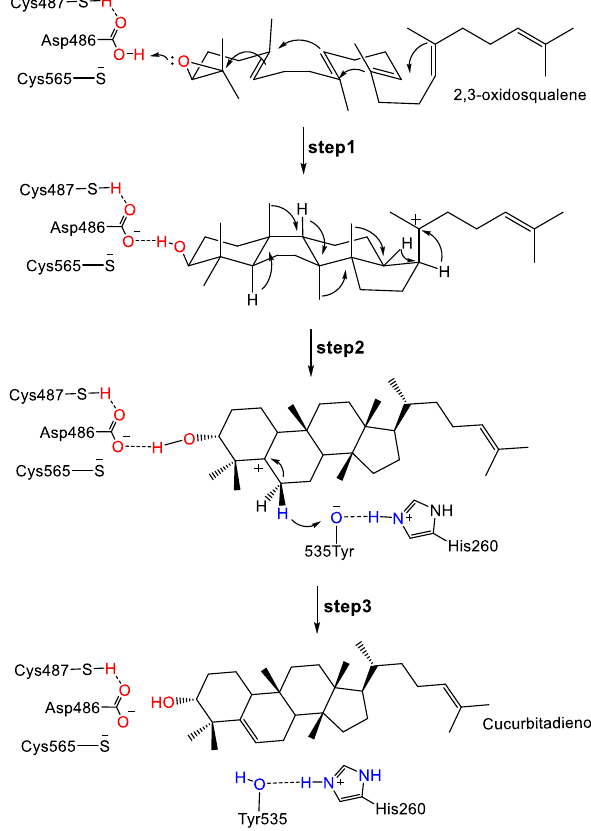
Figure 6. A proposed tentative mechanism for the SgCS-catalyzed cyclization reaction.